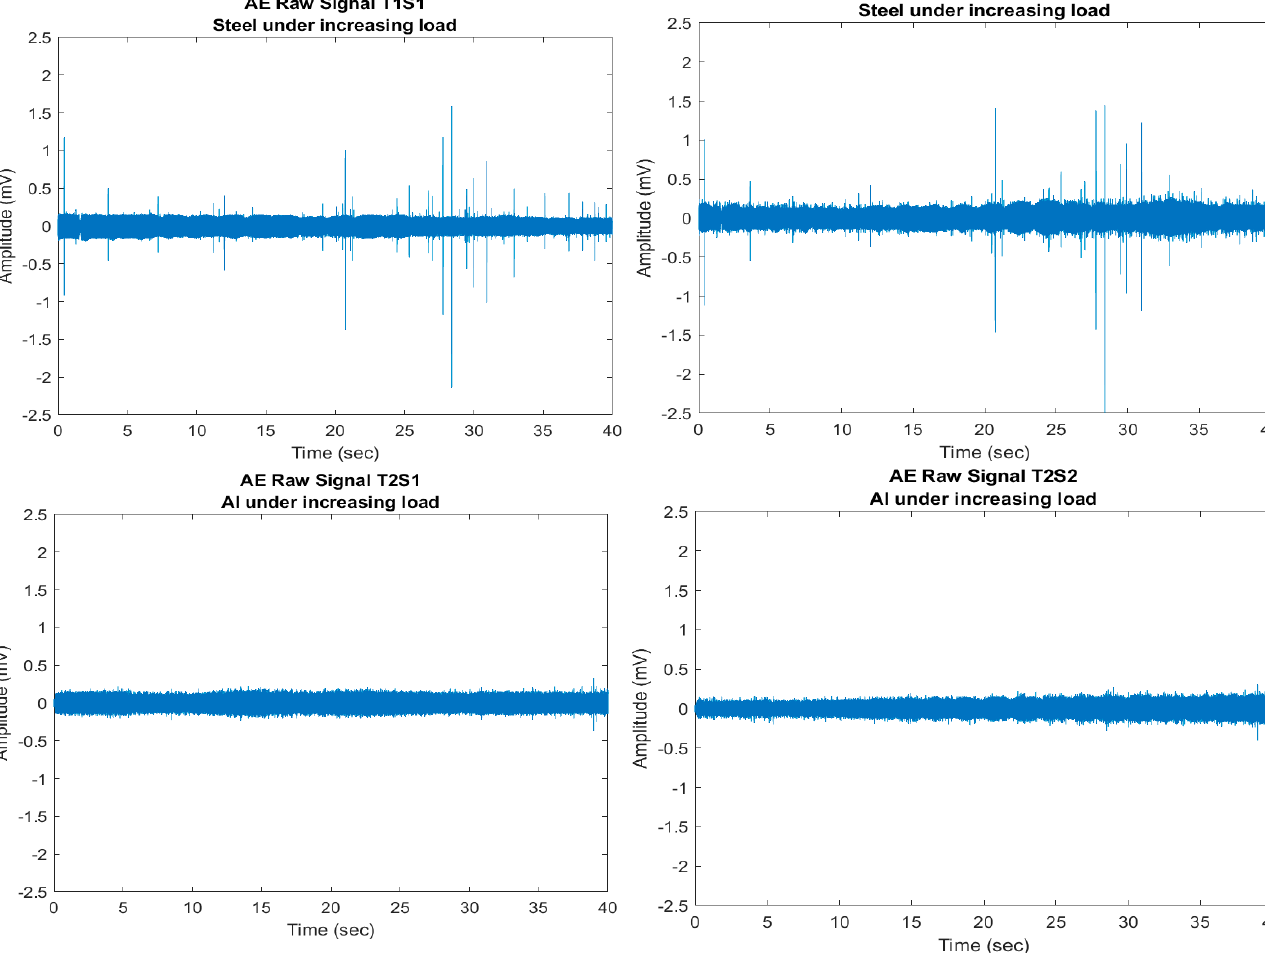
Figure 6. Raw signal of the scratch tests under increasing